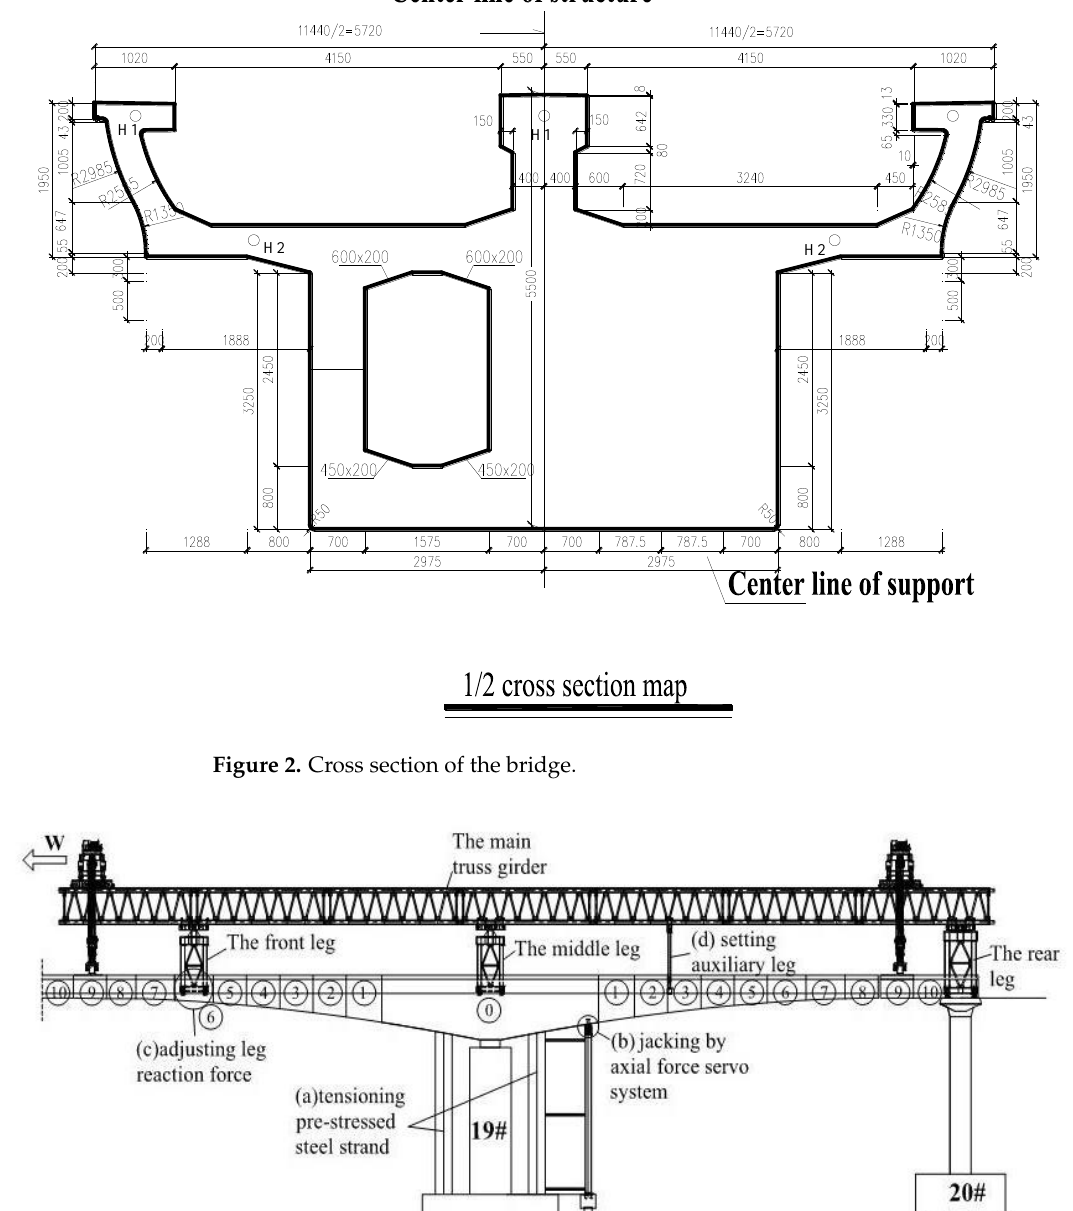
Figure 3. Four mechanical state control methods shown in the eastern half of the